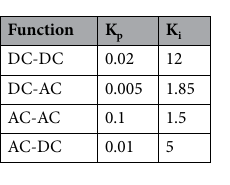
Table 4. Converter controller gains.